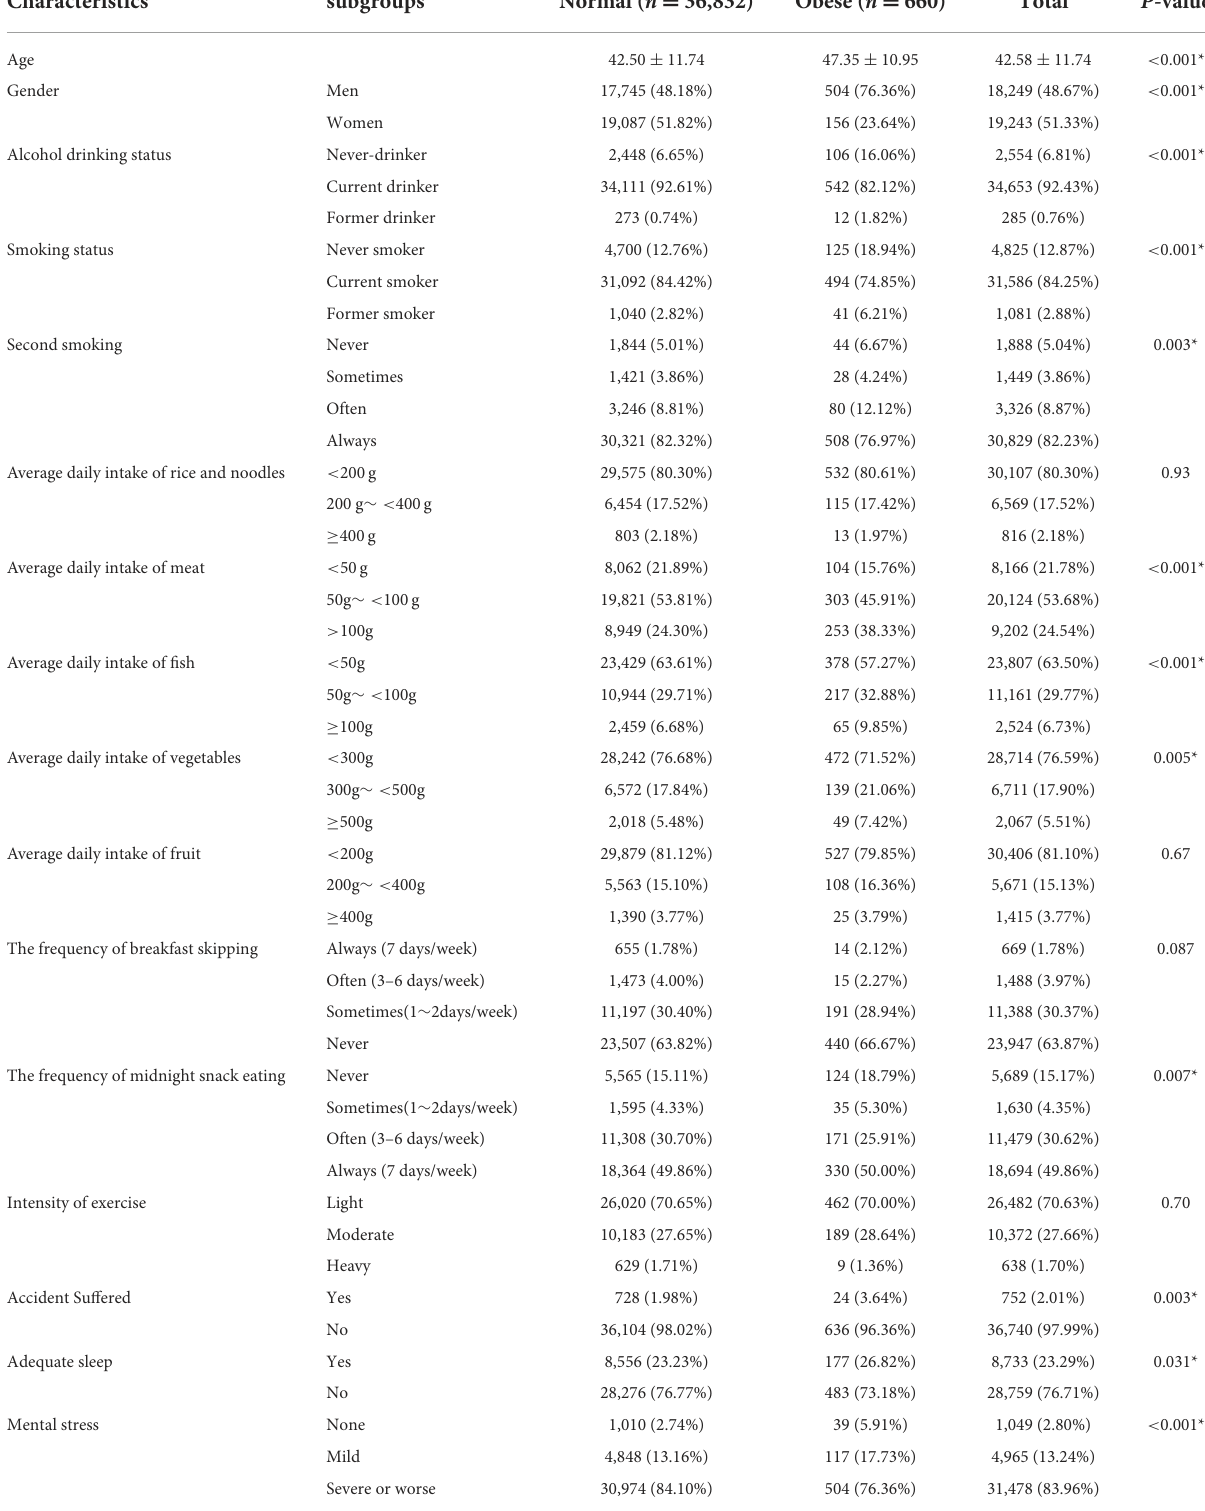
TABLE 1 Health behavior characteristics of the obese and non-obese population in Chongqing ( N = 37,492).